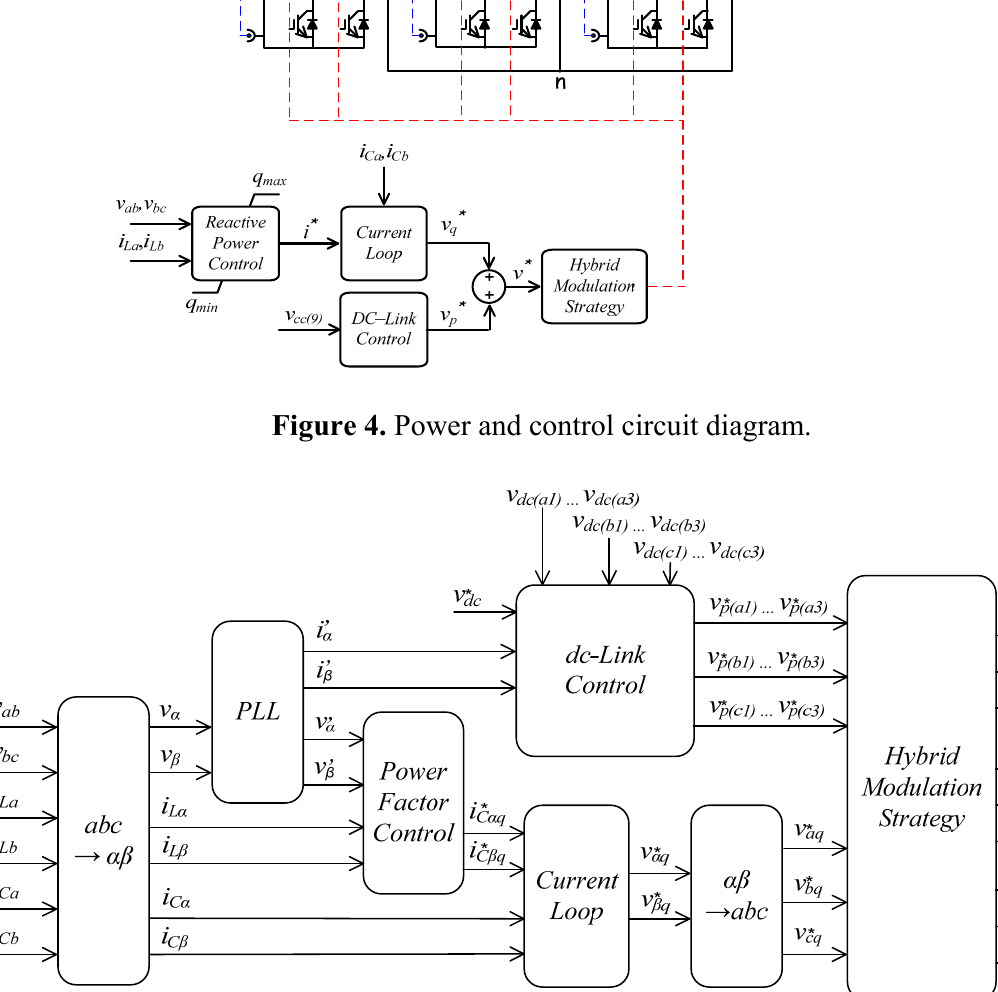
Figure 5. Control circuit